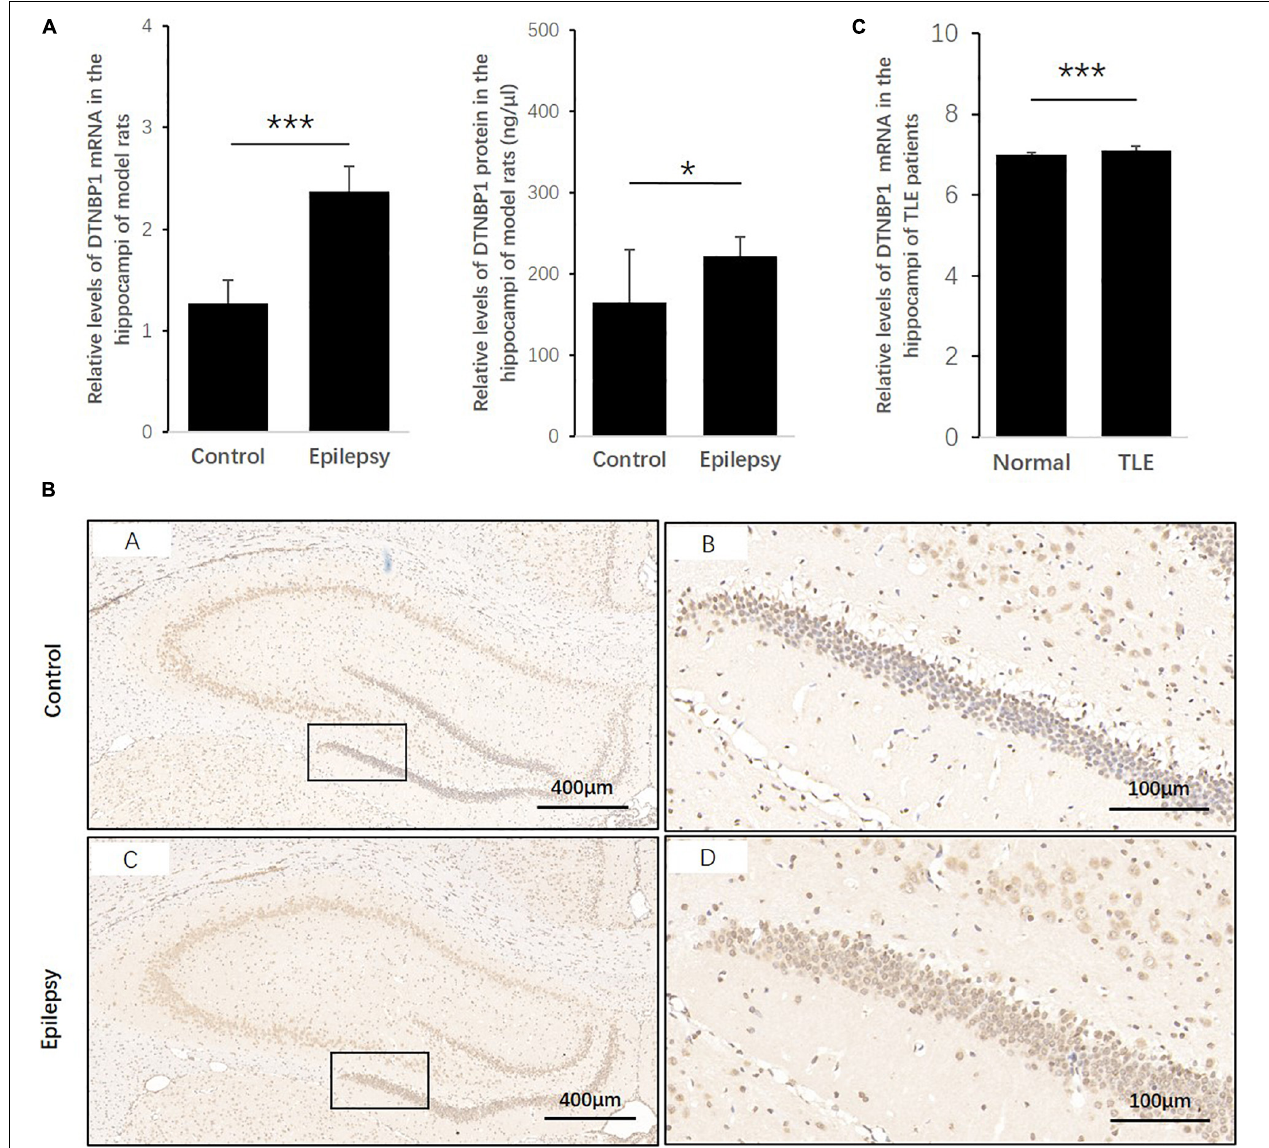
FIGURE 3 | Expression patterns of DTNBP1 in an epilepsy rat model and TLE patients. (A) According to qPCR, the relative levels of DTNBP1 mRNA in the hippocampi of normal rats and epilepsy model rats were 1.27 ± 0.23 and 2.37 ± 0.25, respectively. (B) According to ELISA, the concentrations of DTNBP1 protein in the hippocampi of normal rats and epilepsy model rats were 164.60 ± 64.93 and 222.42 ± 23.20 ng/ µ l, respectively. (C) A total of 129 TLE patients from the GSE63808 dataset and 32 normal controls from the GSE29378 dataset were enrolled in the TLE and control groups. After normalization and multiple hypothesis testing to reduce the false-positive rate, the average DTNBP1 mRNA expression in the hippocampi of the TLE and control groups was 7.11 ± 0.09 and 6.99 ± 0.07, respectively. (D) IHC staining is shown individually for global and local regions of the hippocampi. Hematoxylin staining was used to mark the cell nuclei (blue), and immunostaining was used to show DTNBP1 expression (brown). * p < 0.05, *** p <